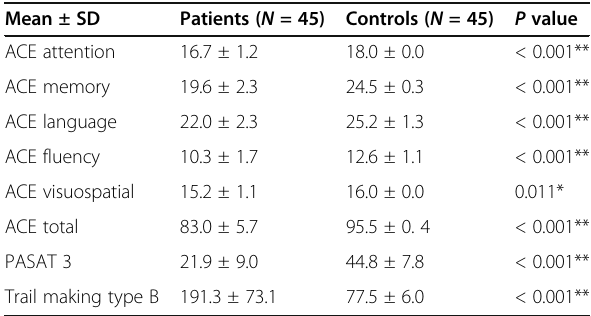
Table 2 Comparison of mean scores of cognitive assessment scales between MS patients and healthy